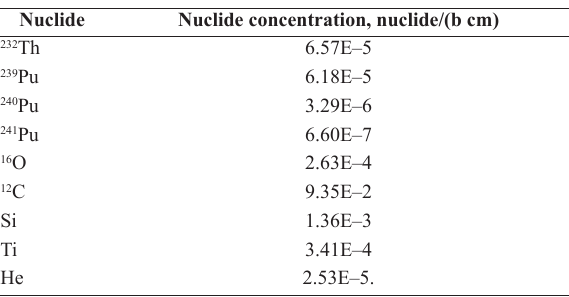
Table 1. Composition of the homogenized fuel part of the